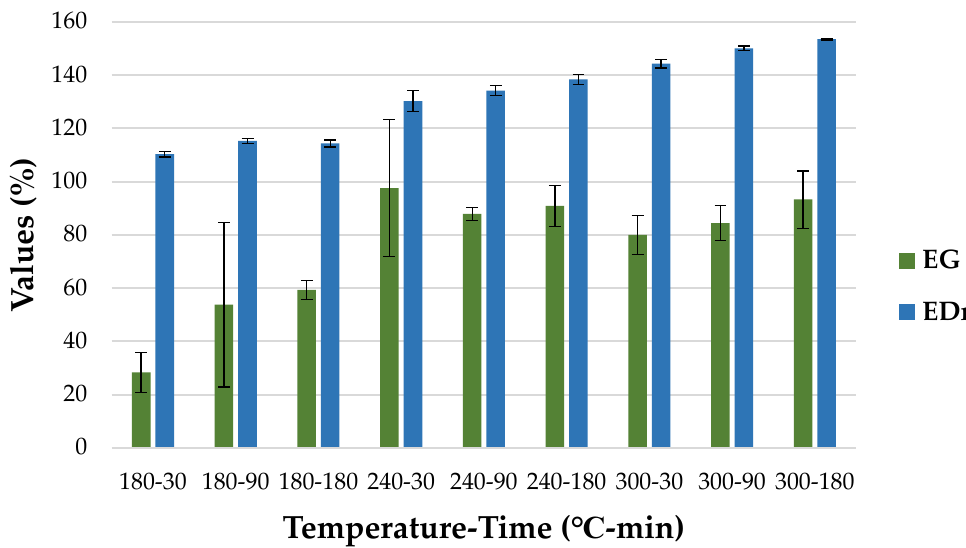
Figure 6. Hydrochar energy densification ratio and energy gain in temperature and time. The highest value of EDr was obtained in HC produced at 300 ◦ C in 180 min (153.56 ± 0.22). Generally, the EDr tends to increase with higher temperatures, which was proven for wheat straw, corn cob, sunflower stalk, and dry leaves [50,52]. Energy gain, which can determine content in the derived HC . As shown in Figure 6, EG tends to increase with temperature and time. This correlation was also observed for the HTC process of eucalyptus-tree residues [37]. However, the highest EG was observed for HC obtained at 240 ◦ C in 30 min, reaching 97.6 ± 25.78%. A statistically significant difference was observed between this HC and products obtained at 180 ◦ C in 30 and 90 min ( p < 0.05) (Table A6). This leads to